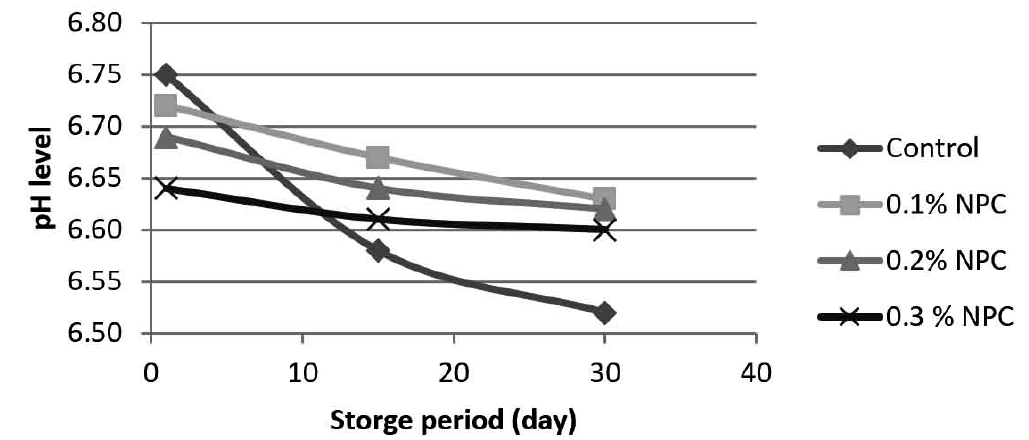
Fig. 3. Changes in pH of pasteurized milk with chitosan nanoparticals (CNP) at different concentrations (0.1, 0.2 and 0.3% w/v) and without CNP during (1, 15 and 30) days of storage at